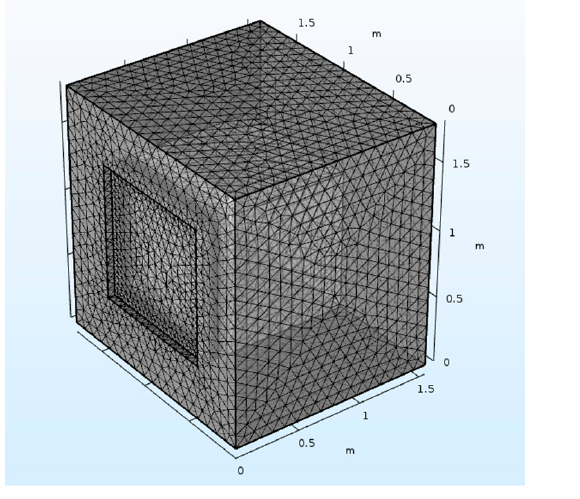
Table 3. Boundary conditions employed during calculation in stationary step.